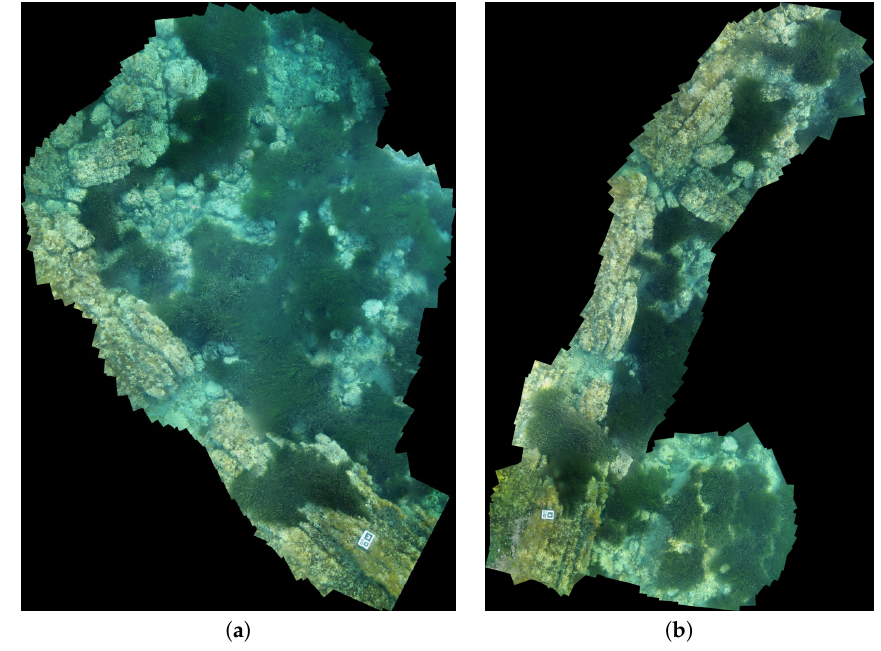
Figure 7. ( a ) Photo-mosaic of S 11. ( b ) Photo-mosaic of S